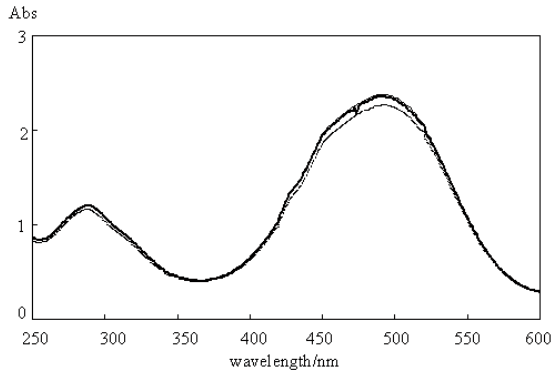
absorption spectra. Conditions as in 12 Fig. 4 except that only 5 cycles were performed.